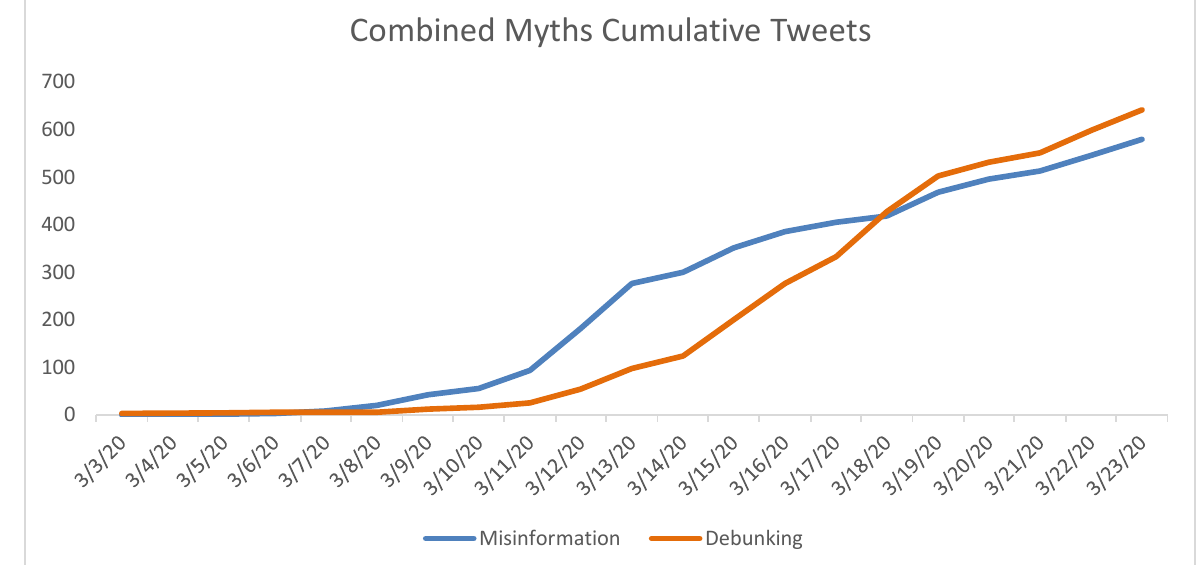
Figure 3. Combined myths cumulative misinformation tweets vs. debunking tweets over